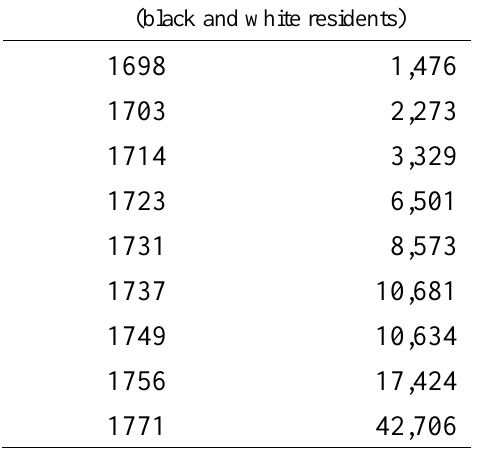
Table 3: Albany City and County Population (black and white